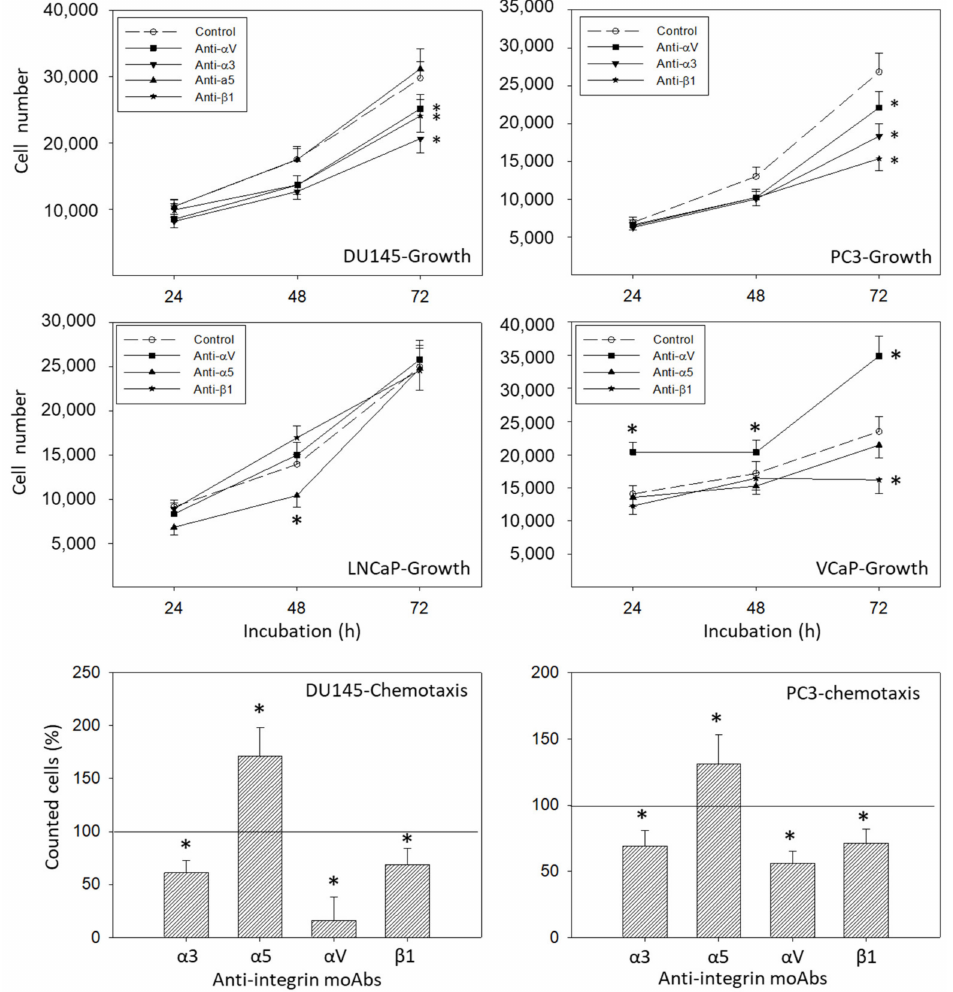
Figure 11. Upper panels: cell growth dynamics of DU145, PC3, LNCaP, and VCaP cells after blockade through monoclonal antibodies against α 3, α 5, α V, or β 1. Controls remained untreated. * indicates significant difference to untreated controls ( n = 4). Lower panels: chemotactic movement of DU145 and PC3 cells after blockade through monoclonal antibodies (specific blockade against α 3, α 5, α V, or β 1). Controls remained untreated. All values are related to the untreated controls set to 100%. * indicates significant difference ( n =